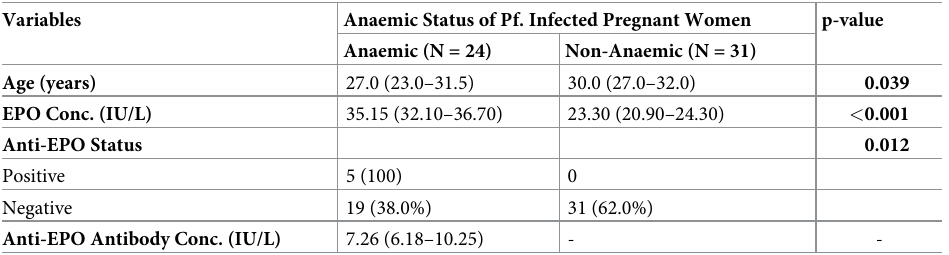
Table 4. Age, serum erythropoietin levels and anti-erythropoietin antibodies levels among the P . falciparum- infected pregnant women stratified by the presence or absence of